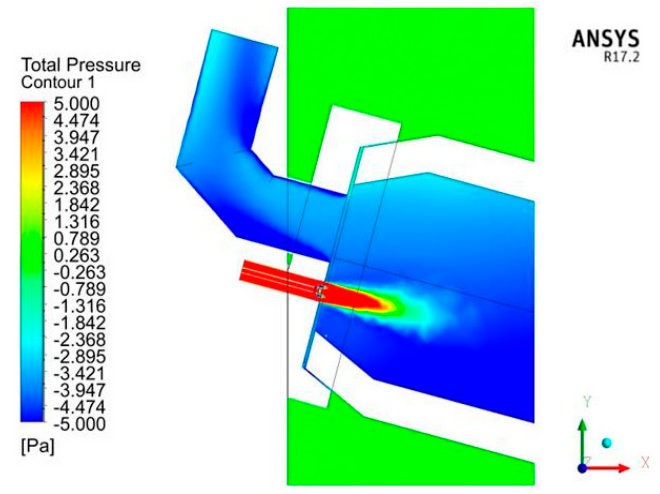
Figure 13. Model results: Pressure contours distribution.